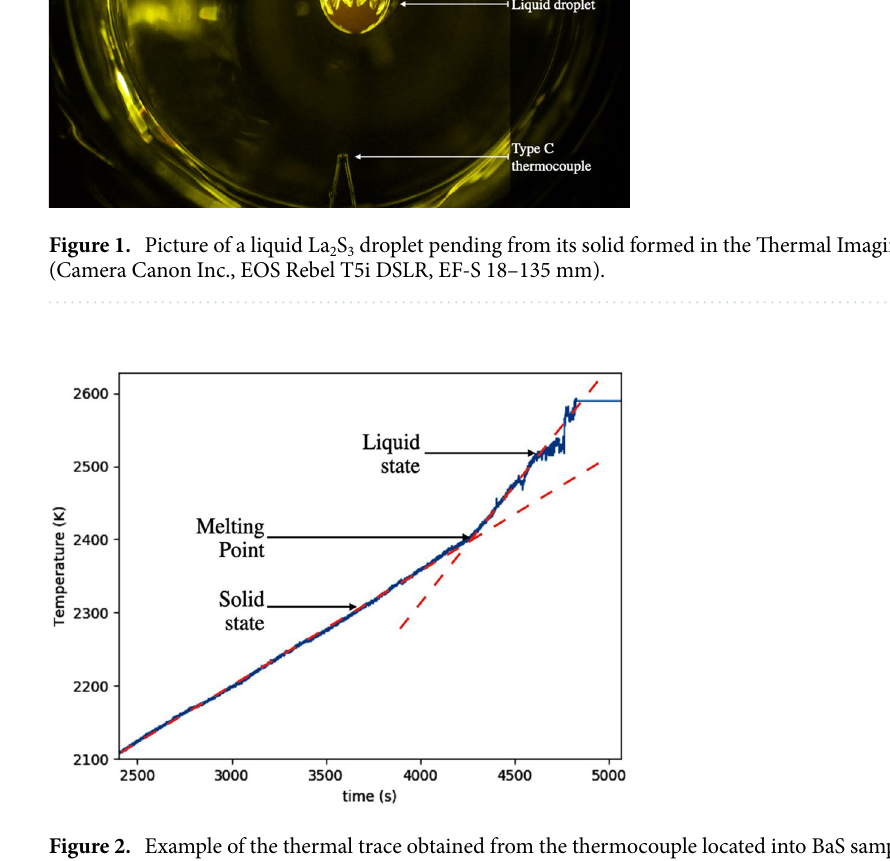
Figure 2. Example of the thermal trace obtained from the thermocouple located into BaS sample. The two dotted lines are used to evaluate the melting